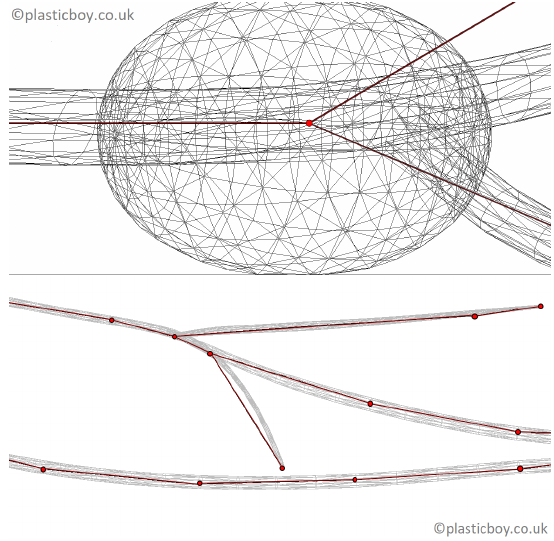
Figure 9. Three-dimensional objects in the lymphatic system model from the PlasticBoy project [20]. ( Top ) The lymph node is an ellipsoid surface object, which has a spatial intersection with at least one lymphatic vessel. ( Bottom ) The lymphatic vessel is a series of cylinder tubes. Polygonal 3D objects are colored in gray; 1D model vertices are colored in red; edges are colored in